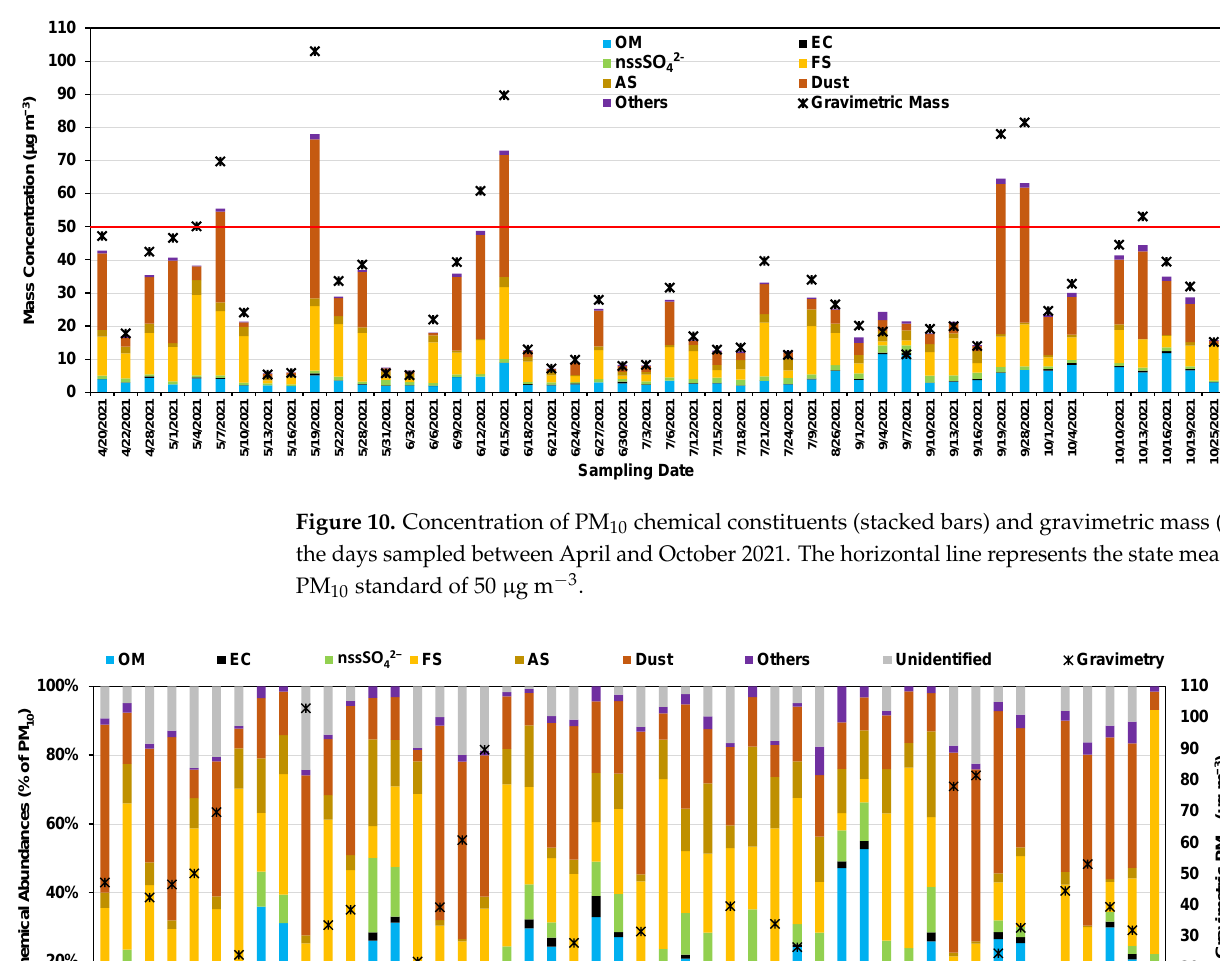
for all sampling days. The PM 10 mass percentages of the chemical constituents in Figure 11 show that while sea salt and mineral dust were the dominant PM 10 constituents during high-PM 10 -concentration days, organics and nssSO 42− contributions were higher during lower-PM 10 -concentration days.